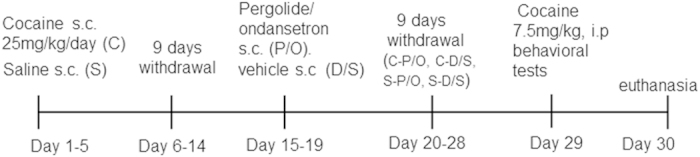
A schematic timeline on the behavioral experiments and experimental design.